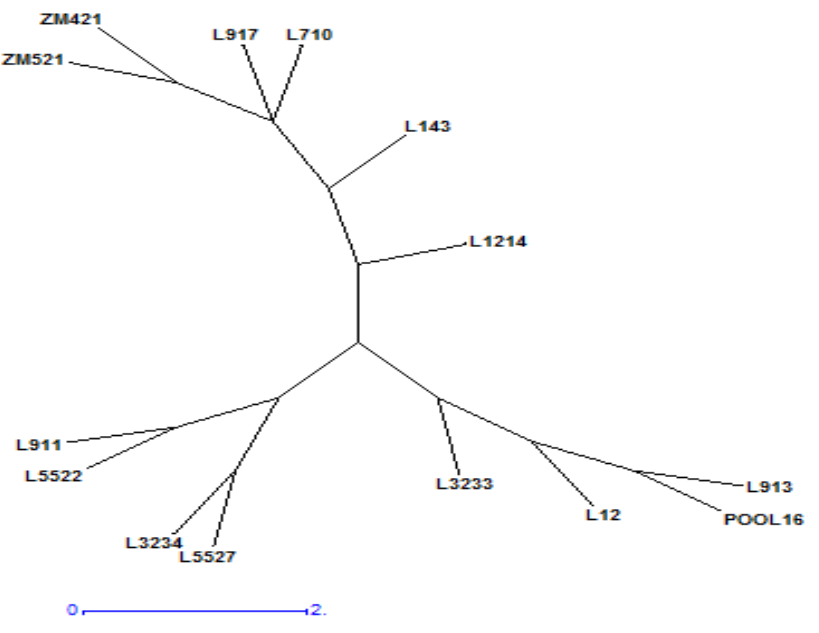
Figure 2. Dendrogram showing clustering of 14 maize